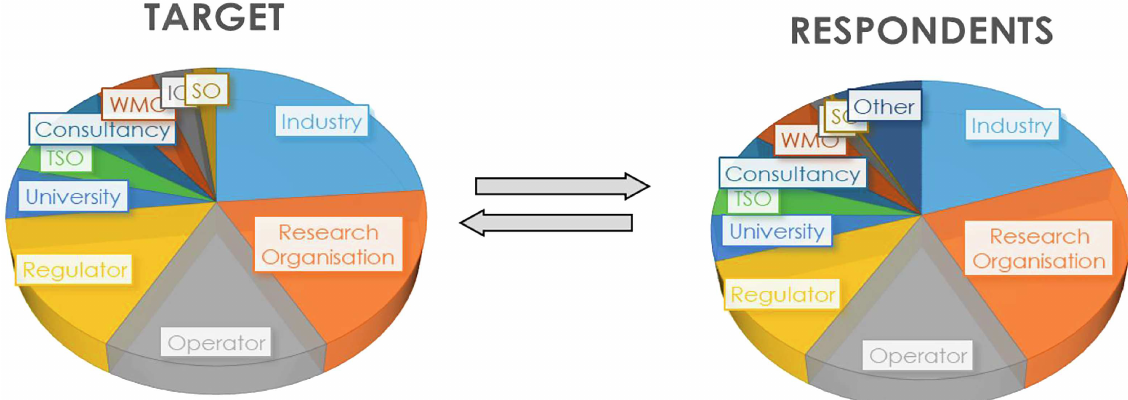
Fig. 3. The population of responding and targeted Stakeholders in the questionnaire survey by their type of